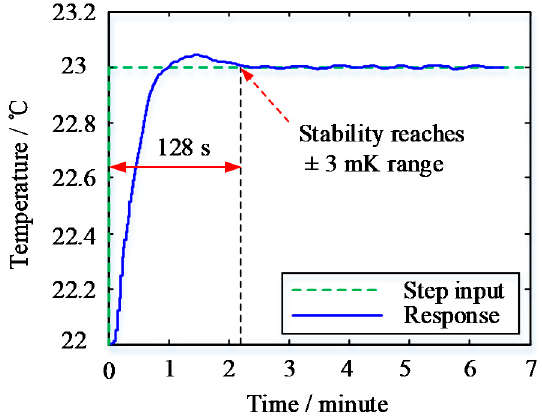
Figure 12. Experimental results of 1 K step response.